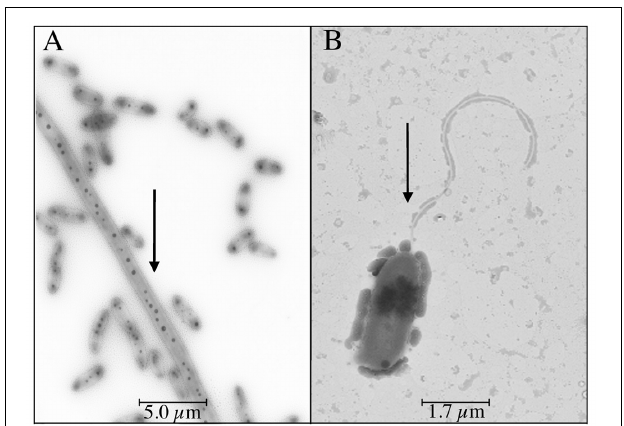
FIGURE 5 | NaCl-dependent flagellum in Vibrio sp. Cells were grown in 0 g/L (A) and 25 g/L (B) NaCl and analyzed by transmission electron microscopy. Arrows indicate the presence of dense granules and flagella,